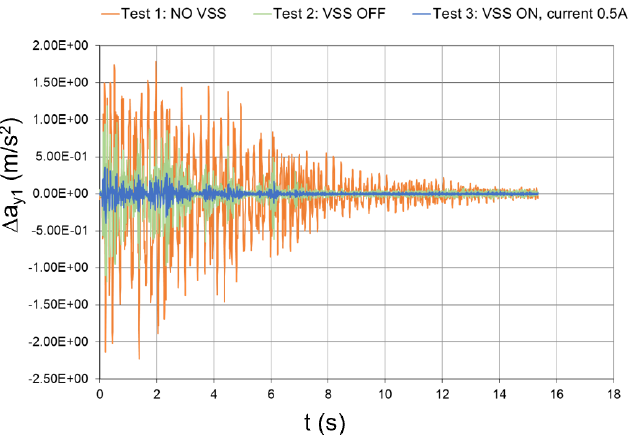
Figure 49. Seismic response (experimental data), interstory acceleration at the 1st floor ( Δ 𝑎 y1 = 𝑎 y1 ).